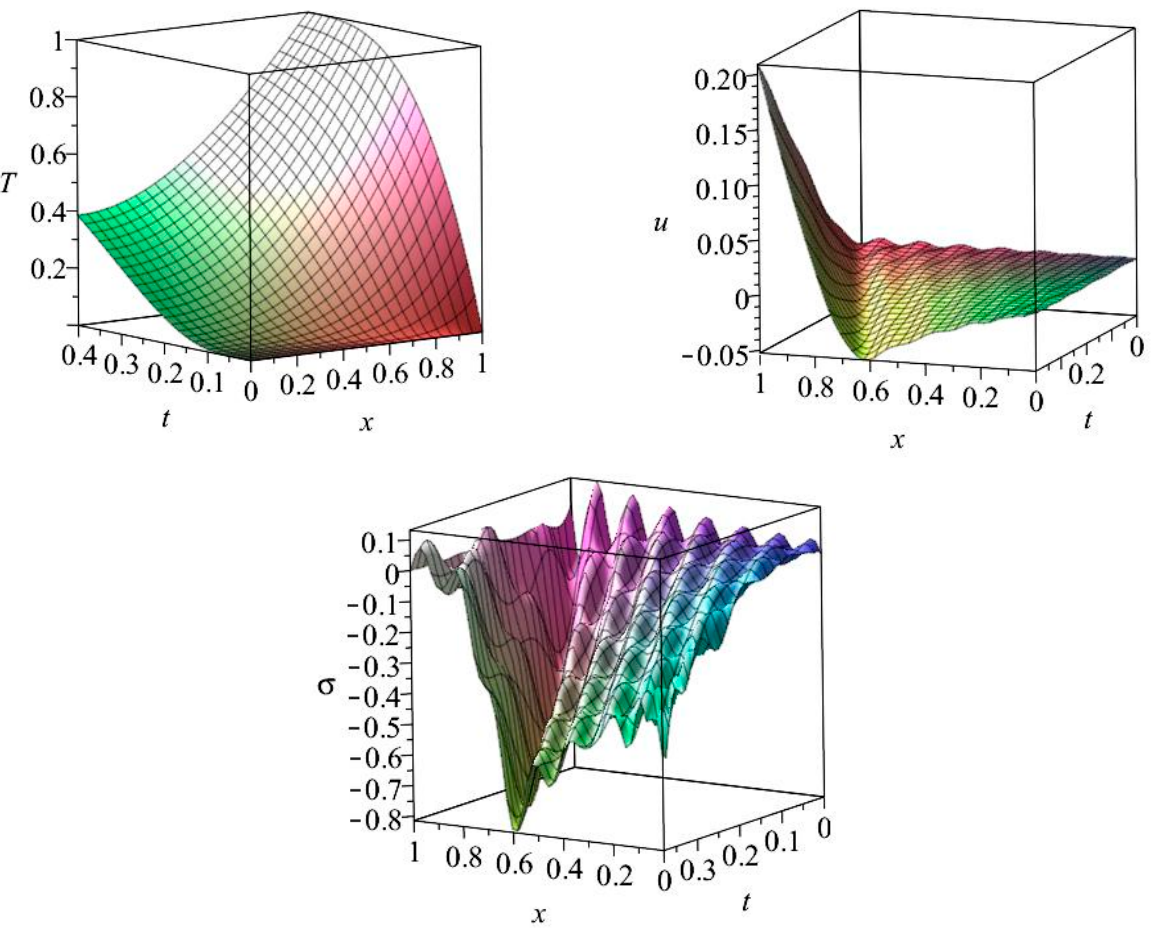
Figure 3. Temperature field, T , displacements, u , and stresses, σ , in one layer. Table 2. The maximum norm for differences (upper row) for boundary condition BC and for temperature, displacement, and stress in the space-time domain.